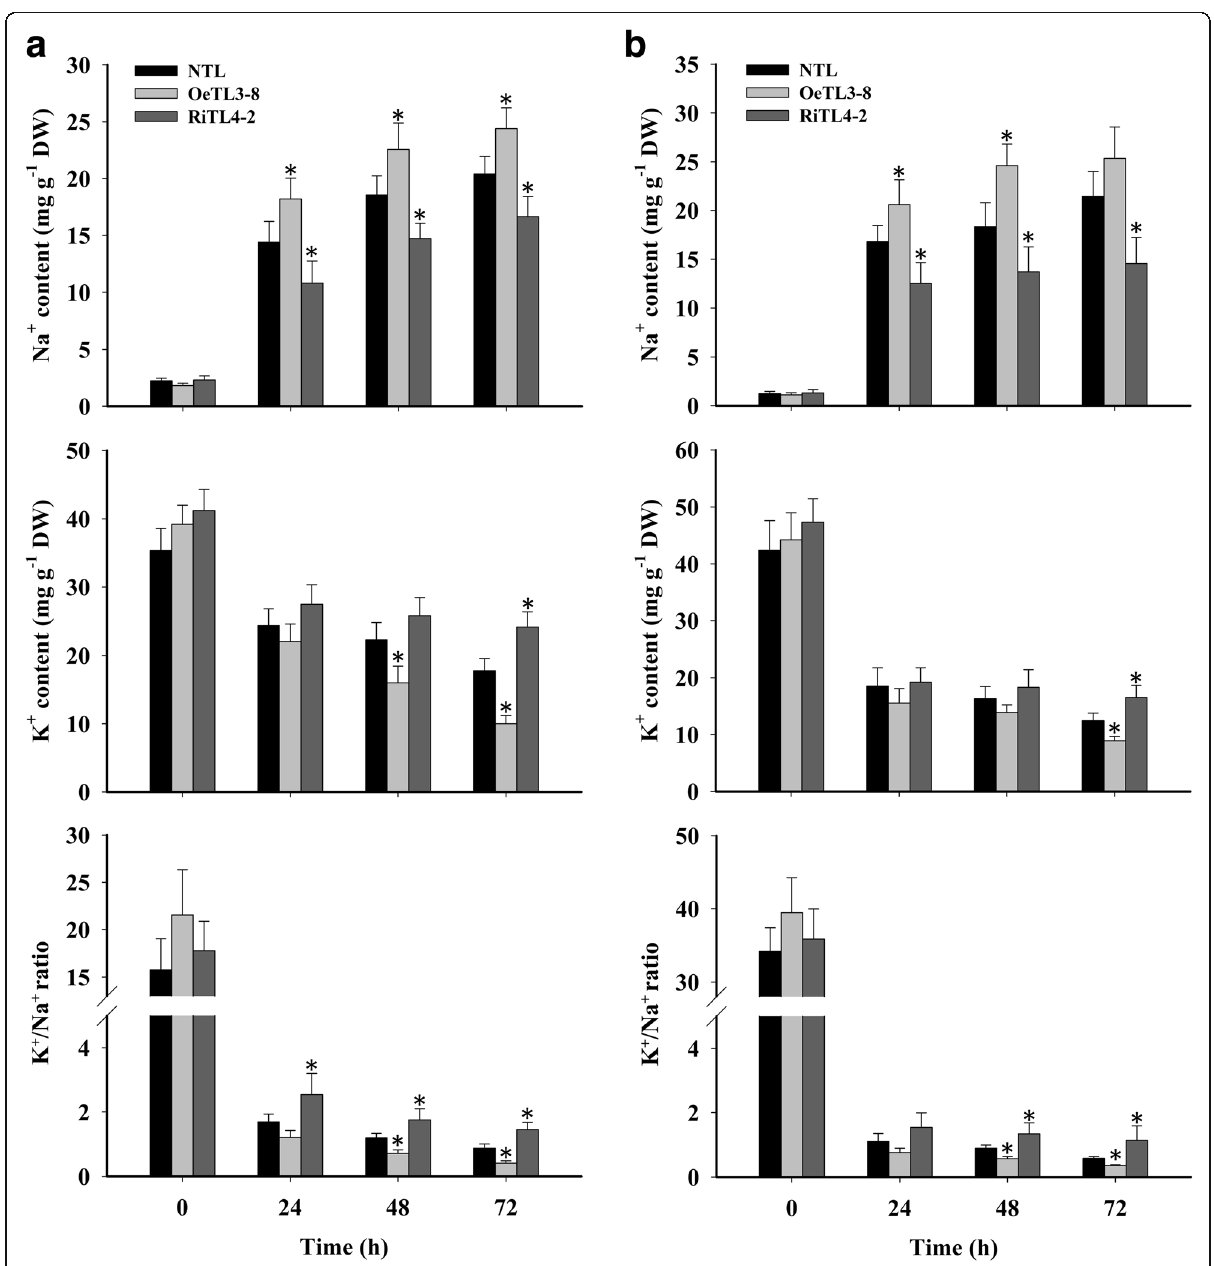
Fig. 4 Na + and K + contents in shoots and roots of various rice plants under salt stress. Ion content in leaf ( a ) and root tissue ( b ) of four-week-old NTL, OeTL3 – 8 and RiTL4 – 2 plants exposed to salt stress (150 mM NaCl) for 72 h. Values shown are for Na + and K + together with changes in the K + /Na + ratio over time. Sixty seedlings per genotype (twenty seedlings for each biological replicate) were used. Data shown are the means ± SE of three biological replicates. An asterisk indicates a significant difference ( P < 0.05) versus stressed